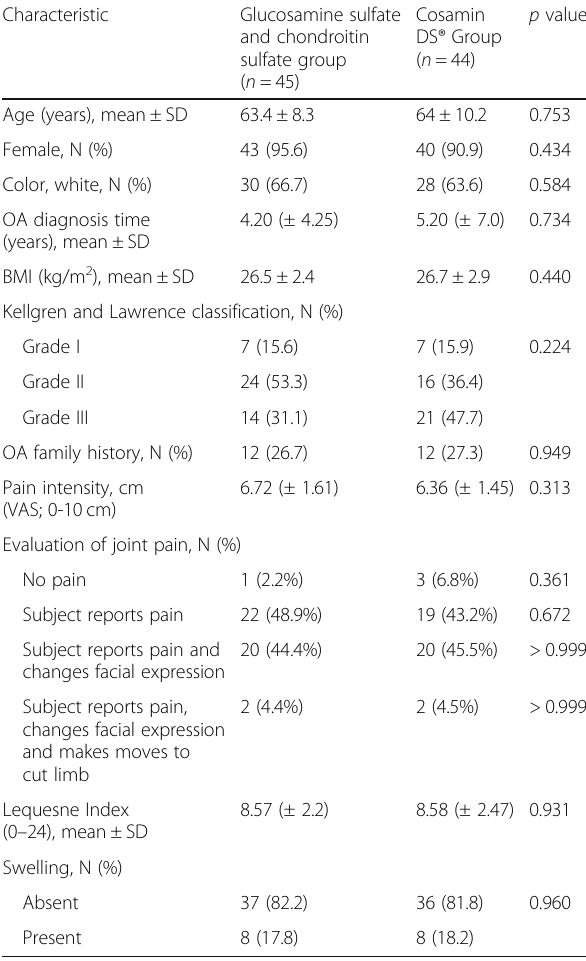
Table 1 Baseline clinical and demographic characteristics in ITT population ( N = 89) Characteristic Glucosamine sulfate and